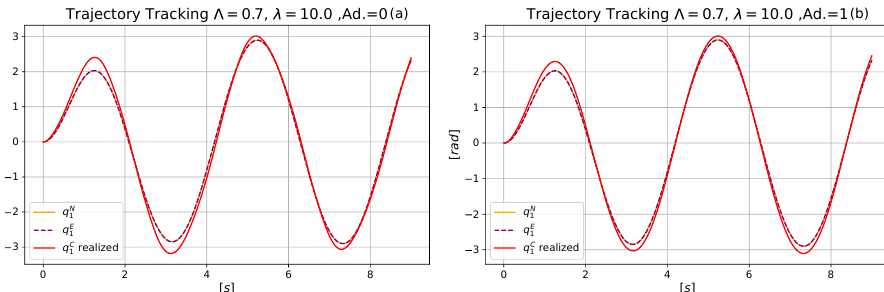
Figure 4. Trajectory tracking for the maximal amplitude and circular frequency of the nominal trajectory for which the adaptive controller was able to use only the originally learned data. ( a ): Non- adaptive, ( b ): adaptive control.